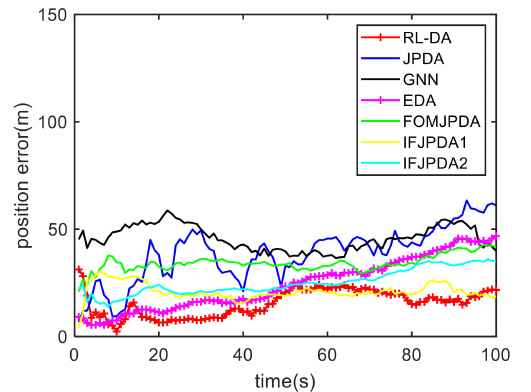
Figure 7. Comparison of the position errors for Target 1 in Case 1.